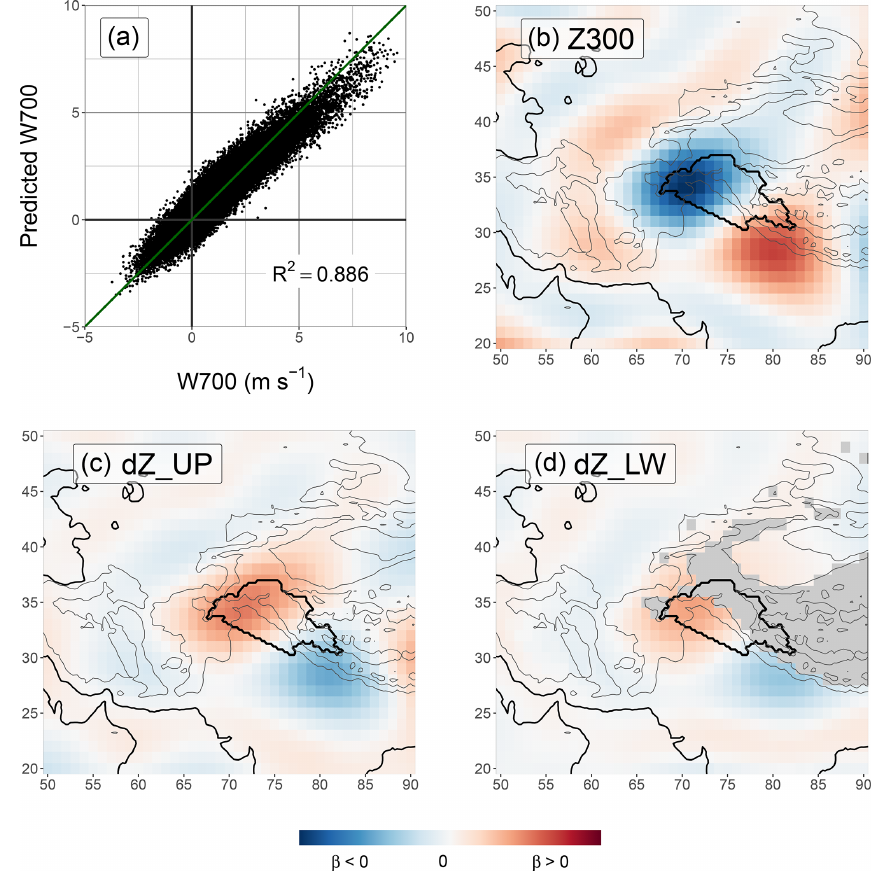
Figure 6. Results of the regression of 3-hourly UV700 with geopotential height at 300hPa (Z300), geopotential thickness 500–300hPa (dZ_UP), and geopotential thickness 700–500hPa (dZ_LW). Panel (a) is the scatter plot between the predictand and the prediction. Panels (b) , (c) , and (d) show the coefficients associated with each predictor (cf. Baudouin et al., 2020a, Eq. 5). The exact values of the coefficients are not interpretable and are therefore not